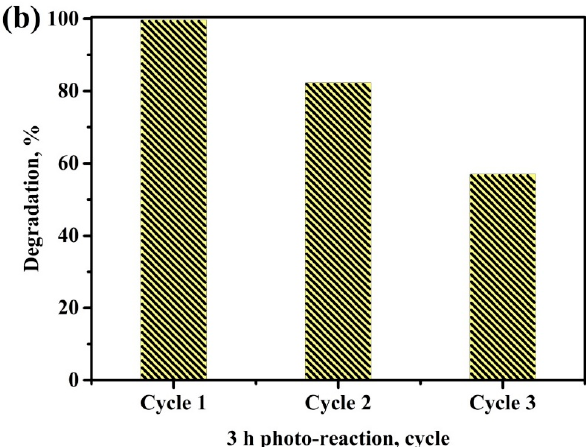
Figure 7. Photo-degradation of the MB solution ( a ) with and without H 2 O 2 for NaYF 4 :(Yb,Er)/TiO 2 , NaYF 4 :(Yb,Er)-CuO and NaYF 4 :(Yb,Er)-CuO/TiO 2 under visible light for 3 h (NaYF represents NaYF 4 :(Yb,Er)) and ( b ) the recyclability of the NaYF 4 :(Yb,Er)-CuO/TiO 2 composite.